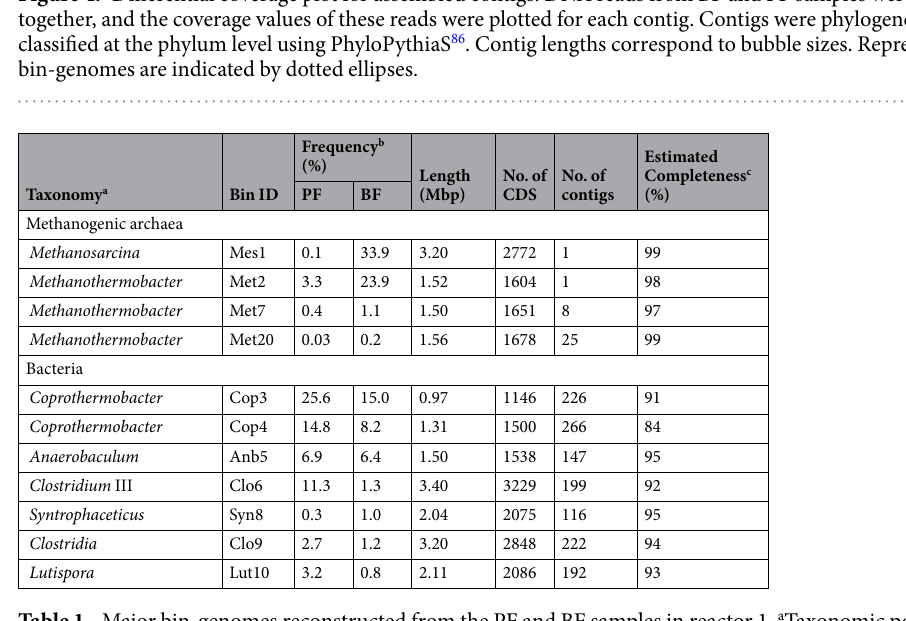
Table 1. Major bin-genomes reconstructed from the PF and BF samples in reactor 1. a Taxonomic positions assigned by RDP classifier with a confidence threshold of 80%. b Calculated based on RPKM values of PF and BF reads for each bin-genome. c Estimated based on the frequency of universal single-copy genes (136 genes for archaea and 105 genes for bacteria) in each